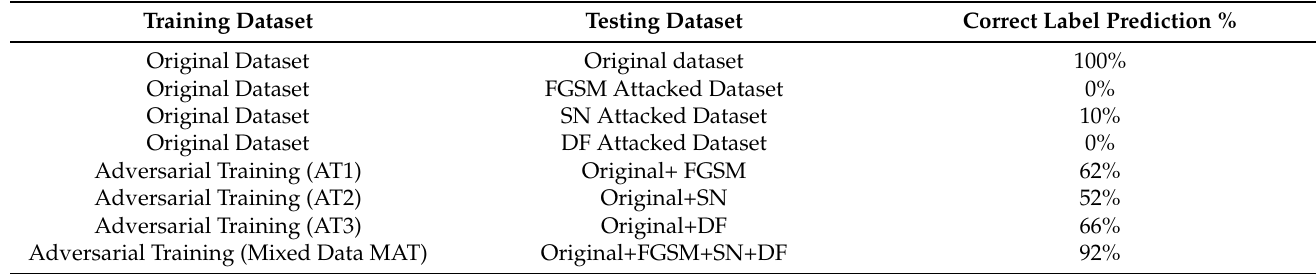
Table 7. Summary of proposed defense model.